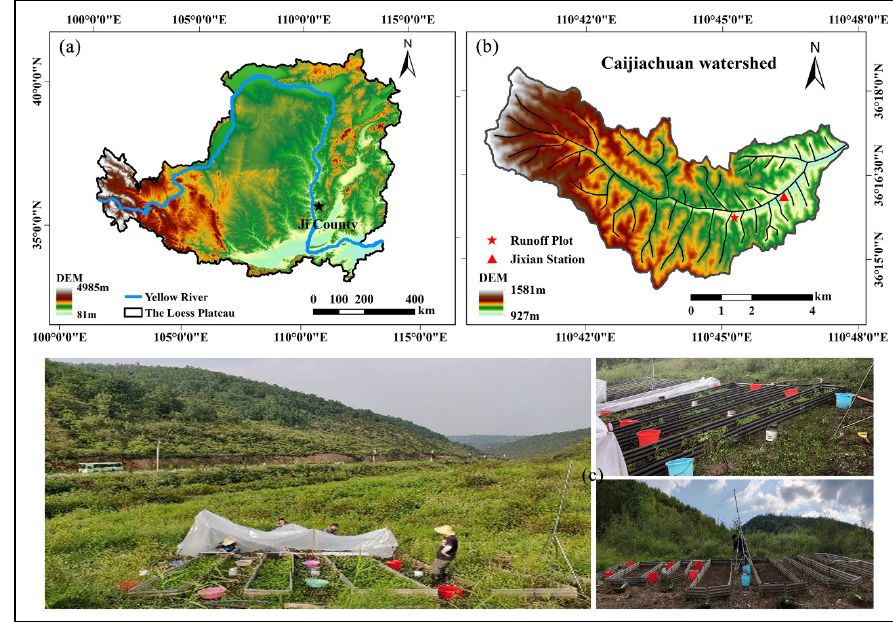
Figure 1. ( a ) The location of the National Field Research Station of Forest Ecosystem in the Cai Jiachuan Watershed, Ji County, Shanxi Province, China; ( b ) the location of runoff plots in the study watershed; ( c ) photograph illustration the landscape of the study areas.